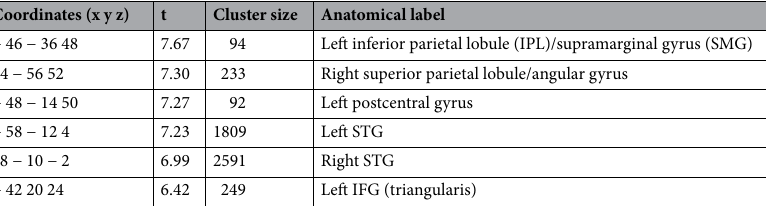
Table 5. Non-parametric random-effects analysis assessing fMRI-based SVM speaker classification accuracy at p < 0.05 FWE-corrected, extent threshold = 20 mm 3 . The 1st column of the table reports the MNI coordinates of local maxima (peaks separated by more than 8 mm); the 2nd column contains t-values assessing that classification accuracy scores across subjects was higher than 33% (height threshold t (1, 36) = 4, p < 0.05 FWE voxel-size corrected); the 3rd column reports relative cluster size; the 4th column contains the anatomical location of the clusters.